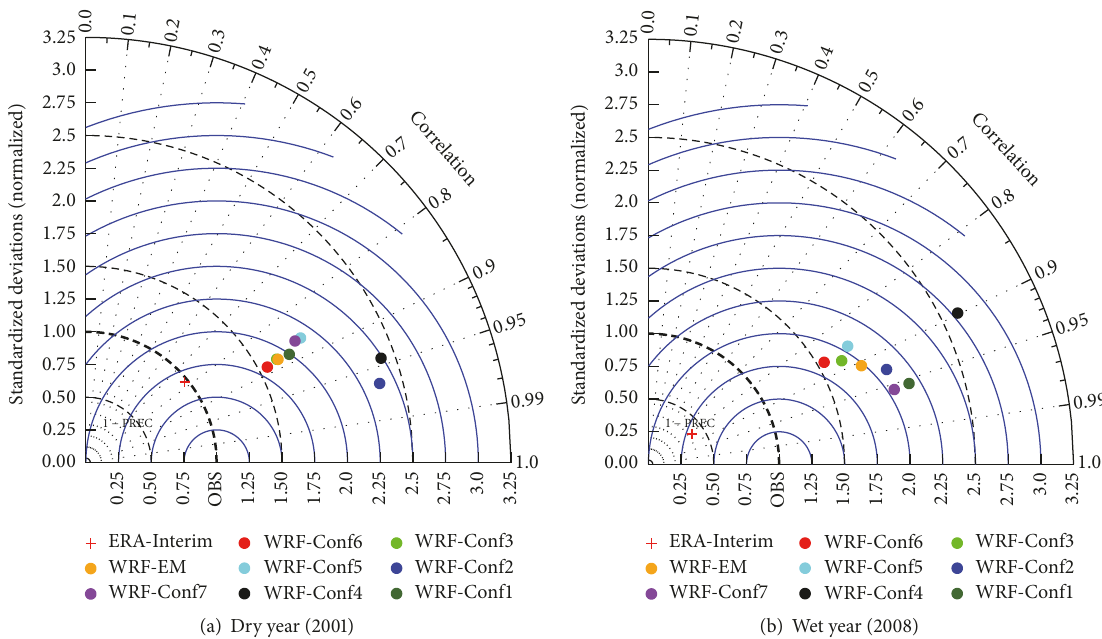
Figure 4: Taylor diagram showing the statistical summary for Ghana for the (a) dry year (2001) and (b) wet year (2008).